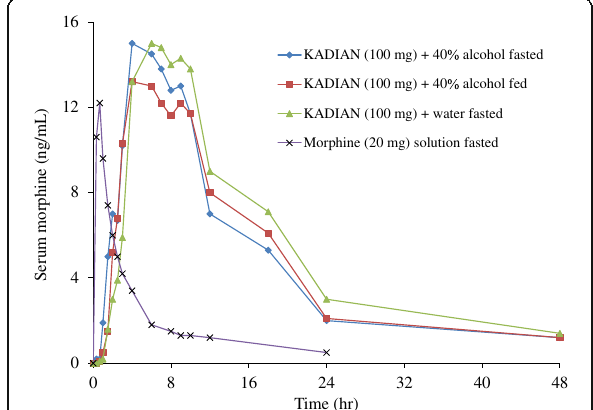
Fig. 2 Mean serum morphine concentration time profiles (data